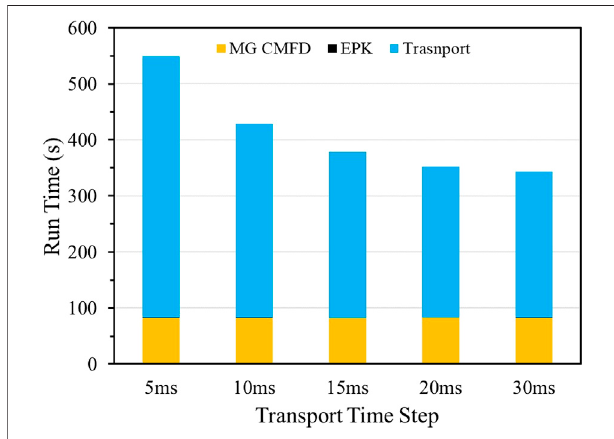
FIGURE 8 | Comparison of total solver run time for different TML